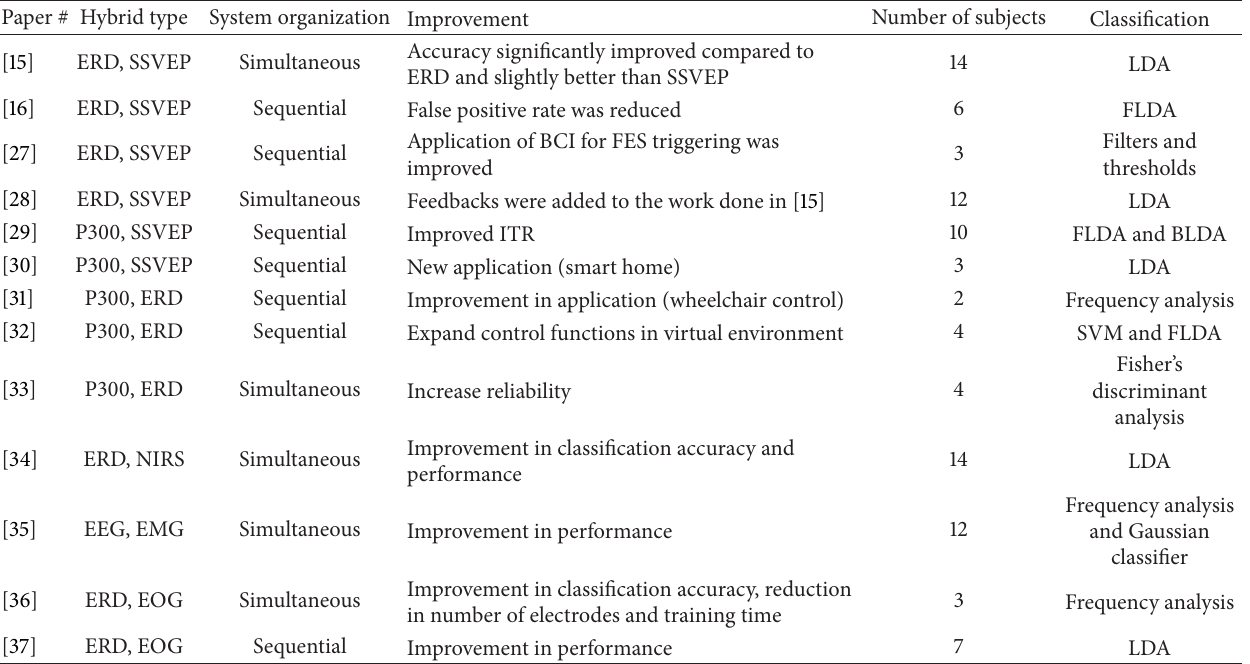
Table 1: A comparison of several different BCI hybrid systems. Paper # Hybrid type System organization